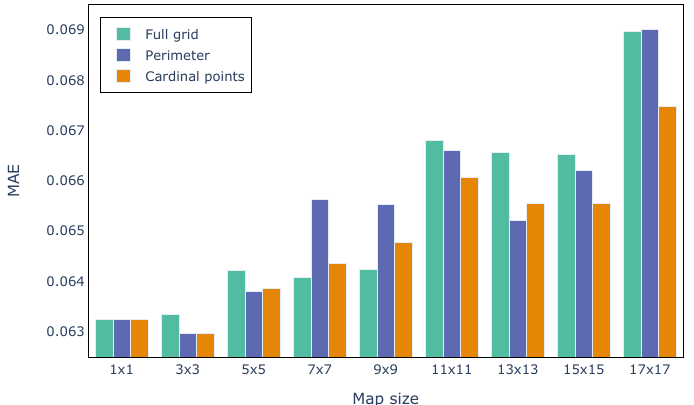
Figure 9. The bar chart shows the MAE averaged over lead times achieved by training separate networks, one for each map size, from 1 × 1 to 17 × 17. In particular, green (left) bars refer to the results obtained by training the networks on full feature maps, purple (central) on perimetric features, and orange (right) on cardinal point